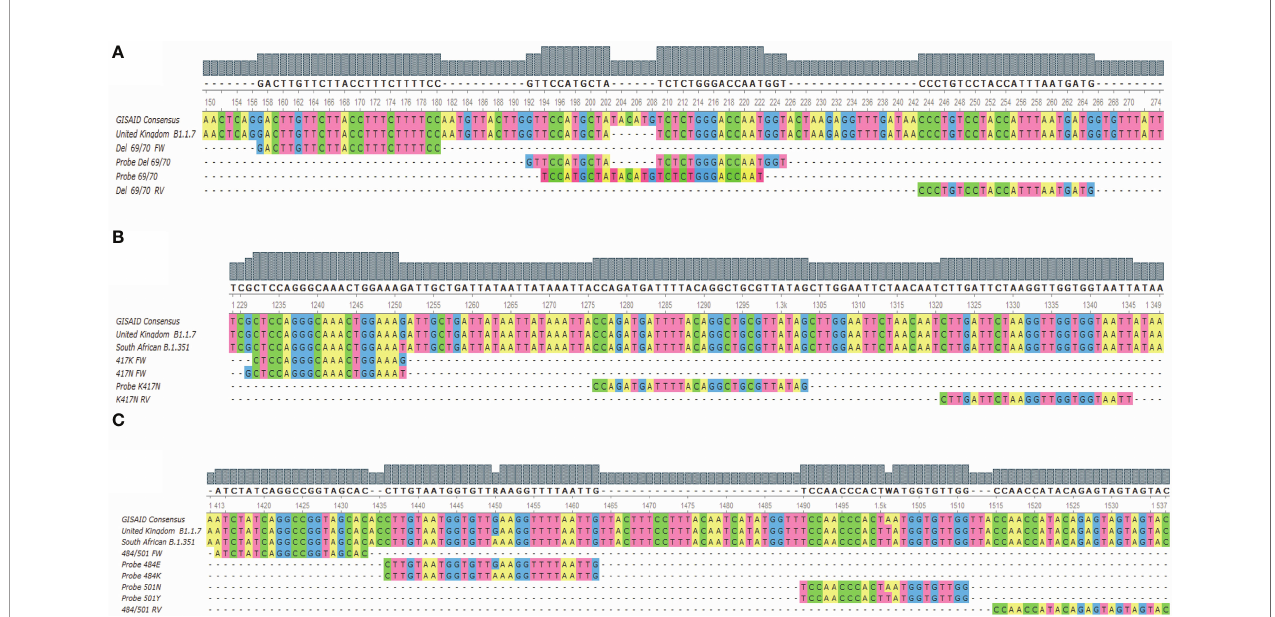
FIGURE 1 | Alignment of the hybridization regions of the oligonucleotides and the probes with the target sequences for the three assays. (A) Shows the alignment for the 69/70 deletion assay; (B) shows the alignment for the K417N mutation assay; (C) shows the alignment for the E484K/N501Y assay. FW, Forward; RV,